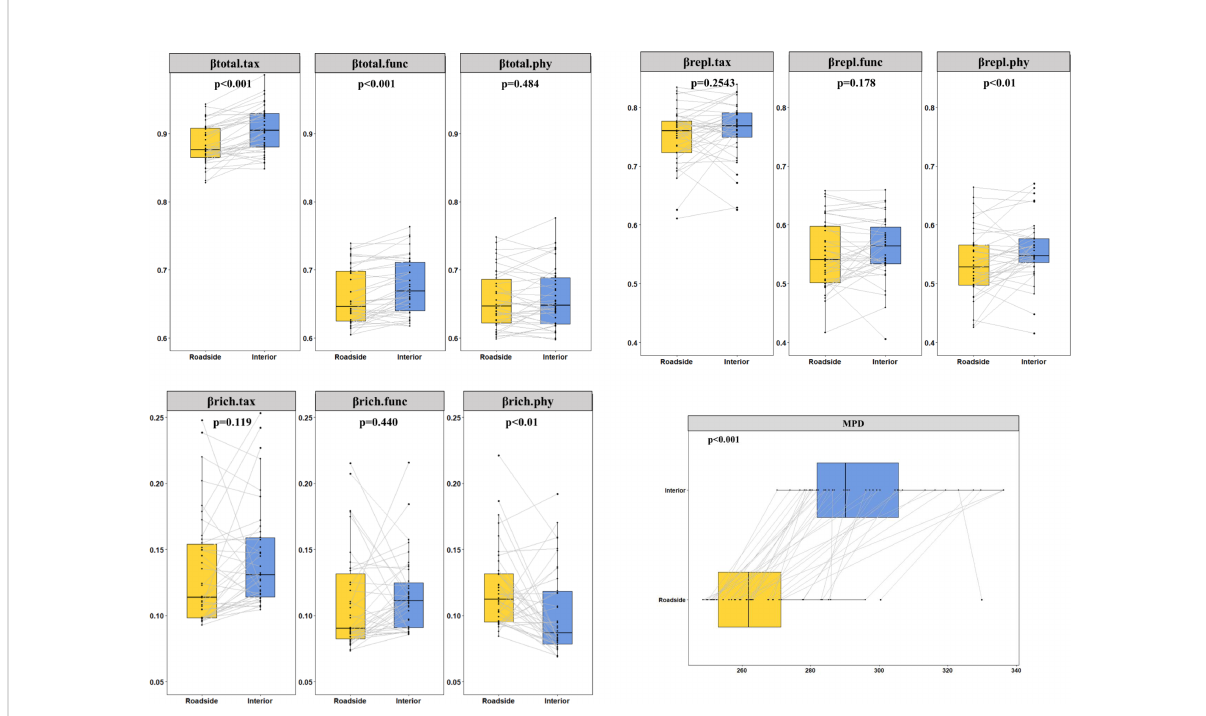
FIGURE 3 Differences between interior and roadside plots were tested with linear mixed models (n=38). The points represent the mean beta diversity of each plot, and the lines connect the beta diversity of the roadside plot and interior plot at the same sampling point. The p value represents the result of the linear mixed effects